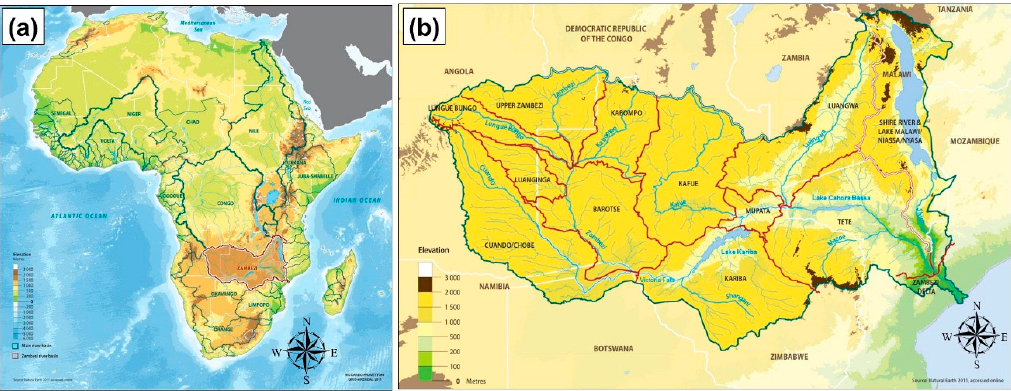
Figure 1. ( a ) Map of the African major river basins. ( b ) Overview of Zambezi catchment area. Maps were adapted from Grid-Arendal website [1].